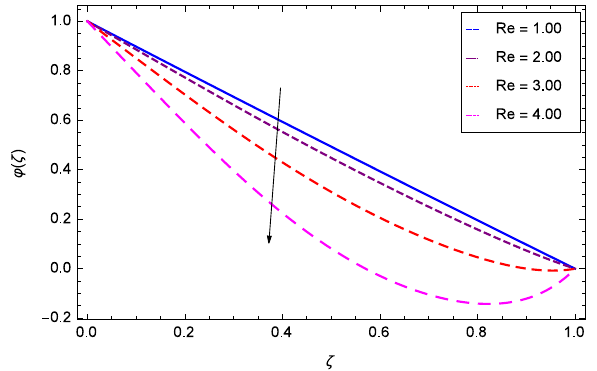
Figure 21. Analysis through Reynods number Re and nanoparticles concentration ϕ ( ζ ).